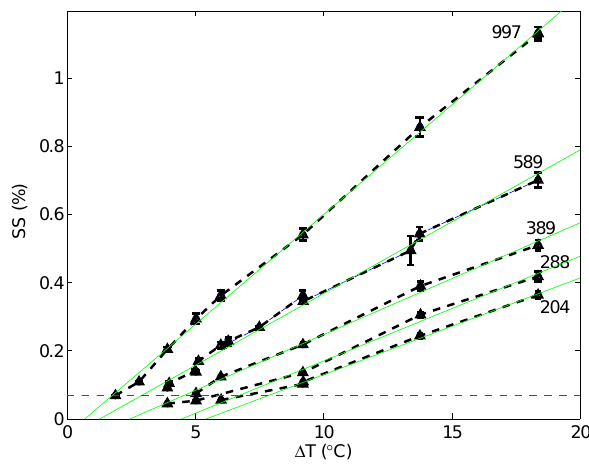
Fig. 2. Calibration of DMT-CCN instrument as a function of tem- perature gradient at different pressures (units: mbar). Green lines are best fits through the data. The red dashed-line represents 0.07% supersaturation (the lower operating limit of the CCN chamber, Roberts and Nenes,